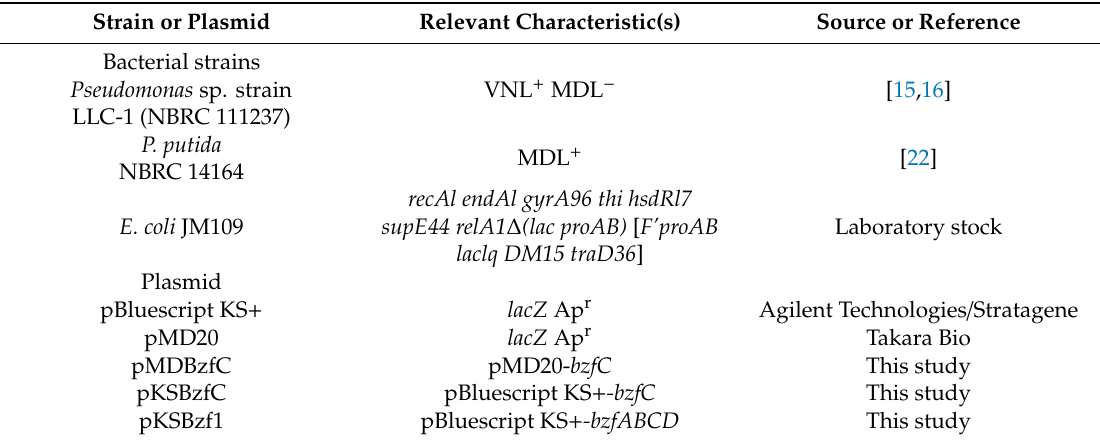
Table 1. Bacterial Strains and Plasmids Used in this